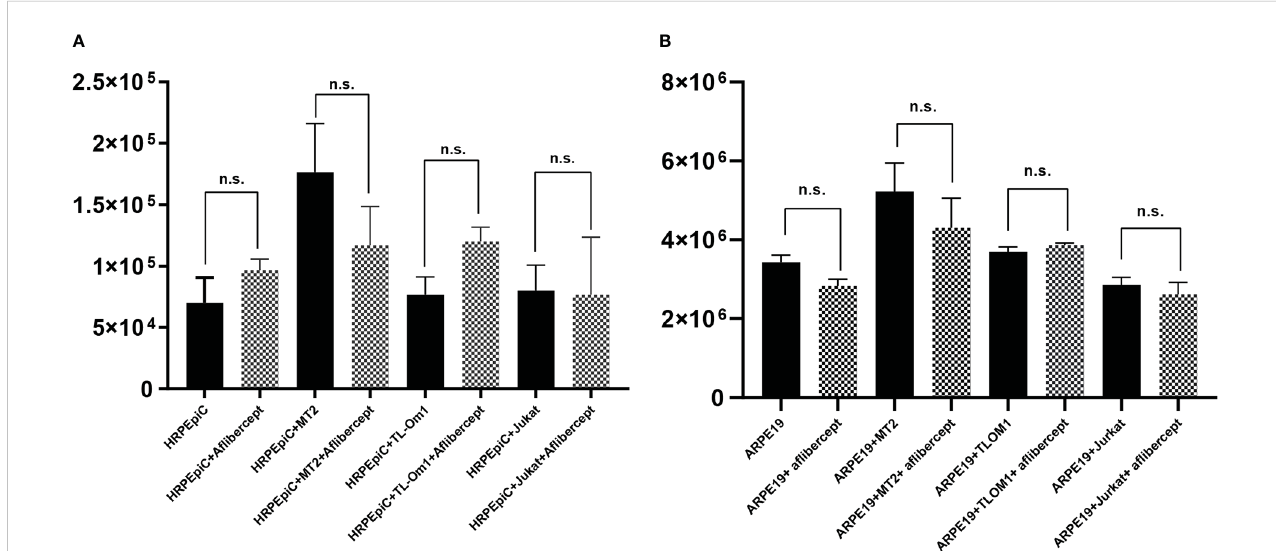
FIGURE 7 Enumeration of HRPEpiCs (A) and ARPE19 cells (B) co-cultured with irradiated T-cell lines or cultured alone; data are number of cells per well with/ without 0.5 mg/mL a fl ibercept after three transfers. The number of HRPEpiCs and ARPE19 cells at the beginning of each culture was 1.5 × 10 5 . No signi fi cant changes in the number of HRPEpiCs or ARPE19 cells were observed in the corresponding groups with a fl ibercept addition. Data are taken from three independent biological experiments and presented as the mean ± SEM (n.s., not signi fi